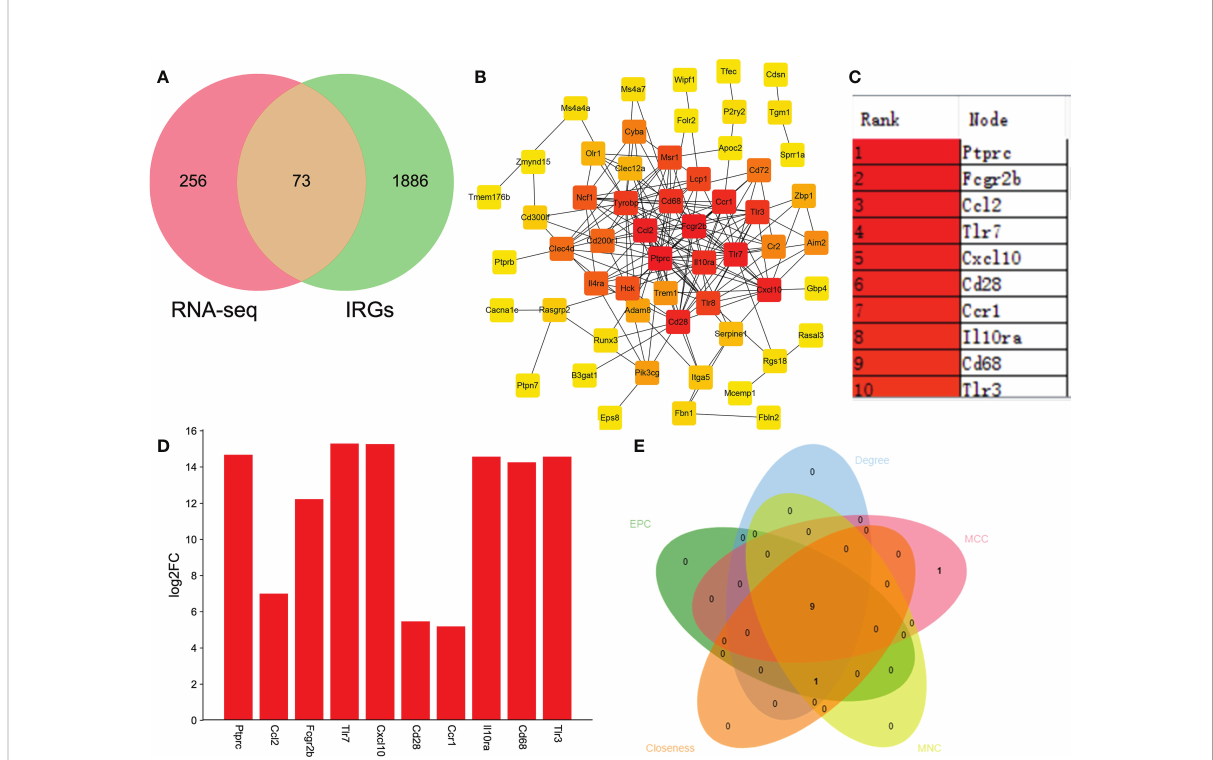
FIGURE 5 Identifying the IRGs related to SCI. (A) Venn analysis to select the overlapping genes between RNA-seq and immune-related genes (IRGs). (B) Identifying the key hub genes via constructing the protein-protein interaction network and further visualizing using Cytoscape software. (C) The top 10 hub genes from PPI network. (D) Bar plot shown the top 10 IRGs related to SCI. The X-axis represents gene and the Y-axis represents log2 fold change. Red means up-regulation, above the X-axis. (E) MCC, MNC, Degree, EPC, and Closeness algorithms were used to verify the obtaining 10 hub genes in Cytoscape